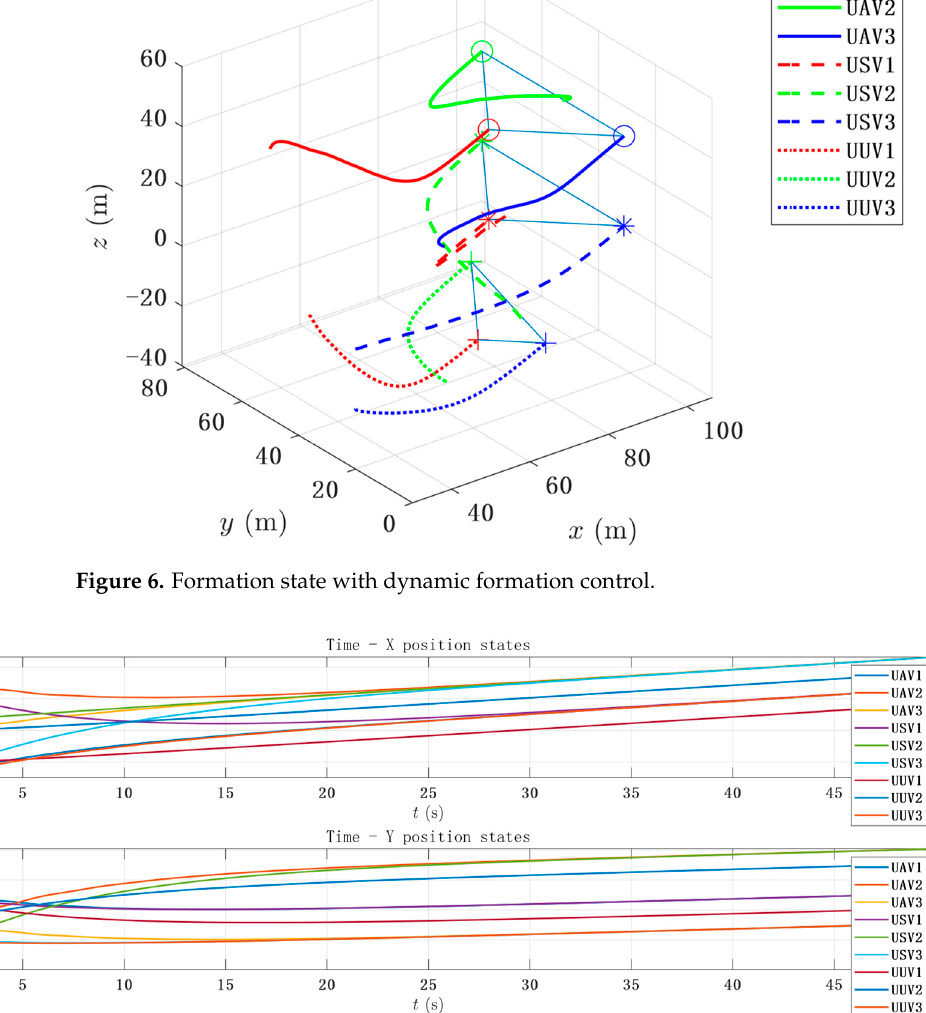
Figure 7. Position state with dynamic formation control.